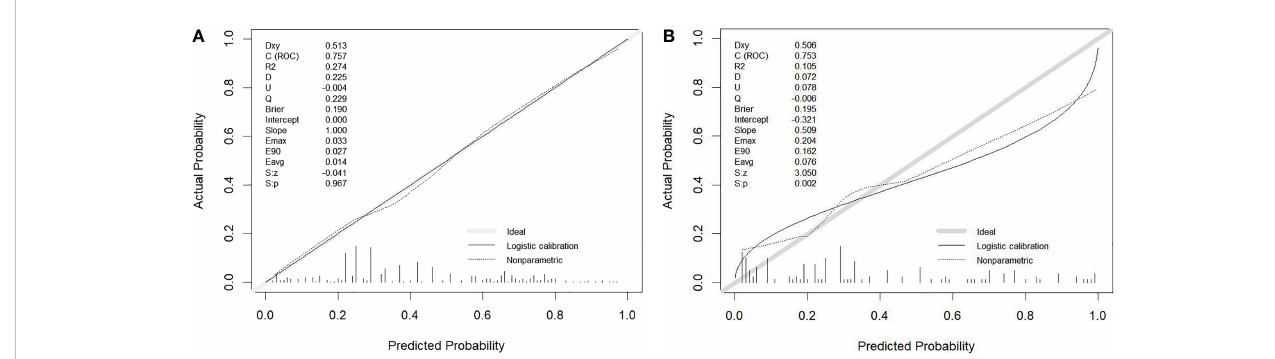
FIGURE 4 Calibration curve for prediction model. (A) Training cohort. (B) Validation